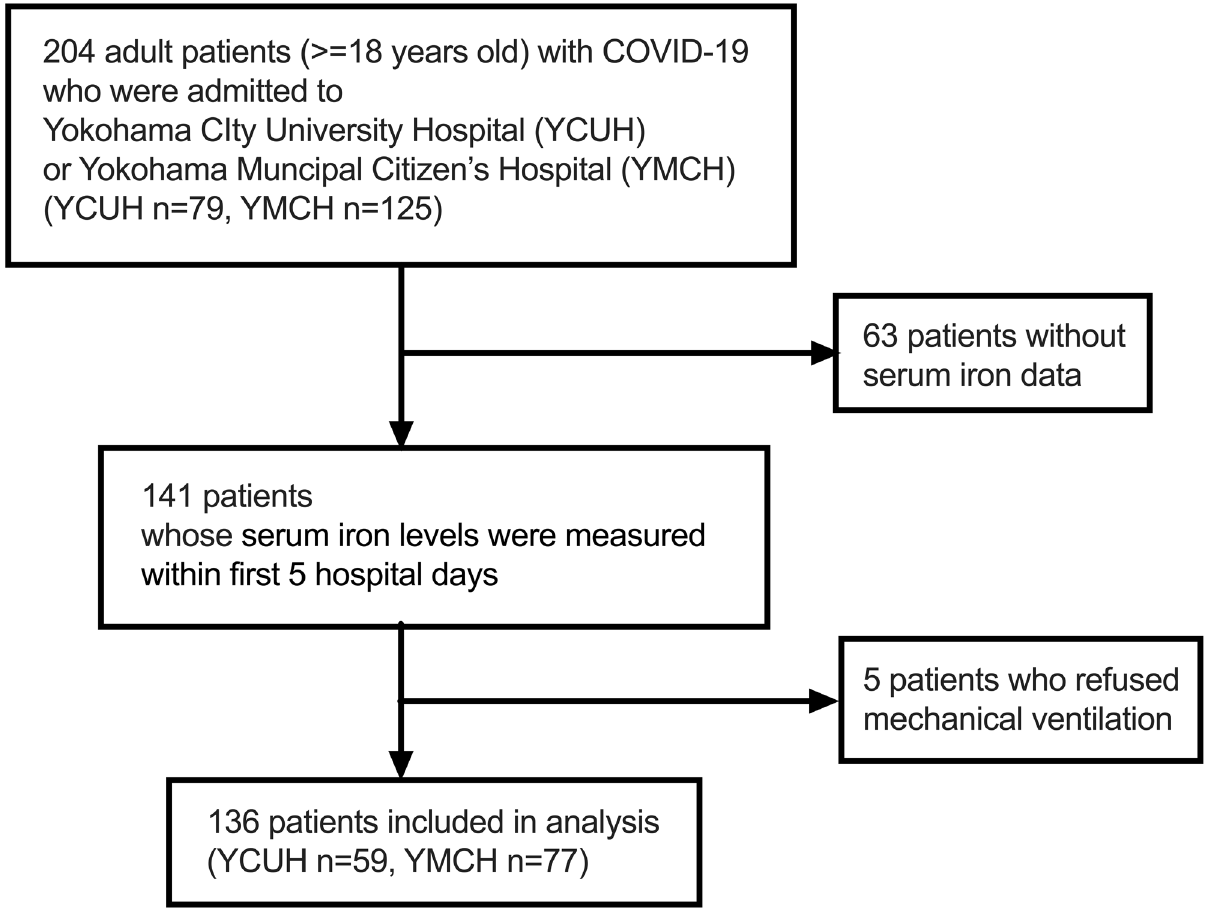
Figure 1. Flow diagram of the patient inclusion.